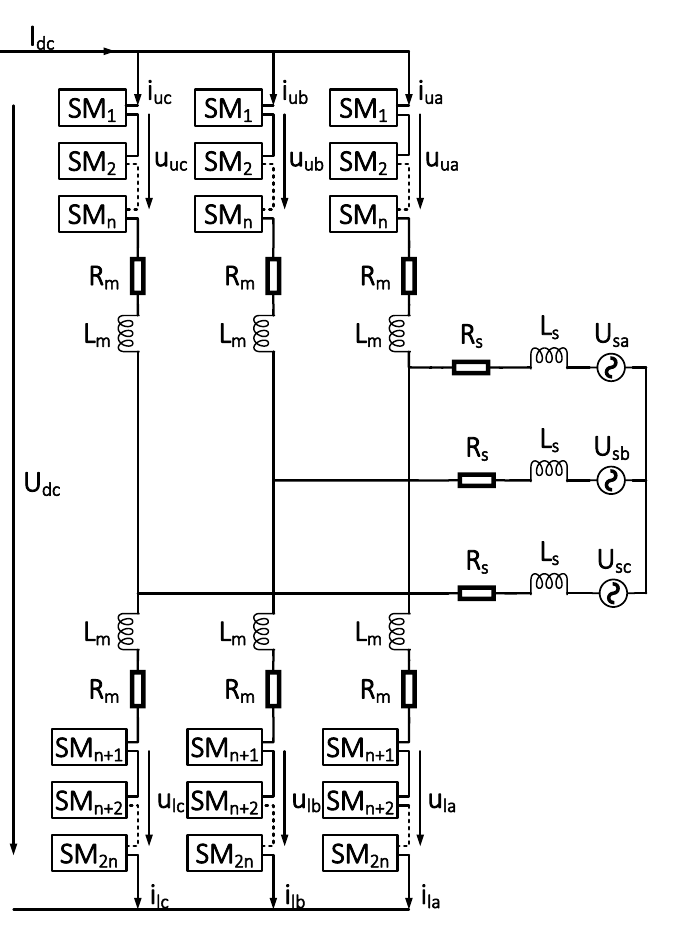
Figure 1. Typical MMC circuit structure. Each SM in the circuit is an independent submodule, and the MMC submodule has two kinds of half-bridge structures and full-bridge structures [16]. Among them, the half- bridge structure submodule is more widely used due to the small number of devices and better economy. The commonly used MMC half-bridge submodule topology is shown in Figure 2, consisting of two power-switching tubes with anti-parallel diodes and a capaci- tor.